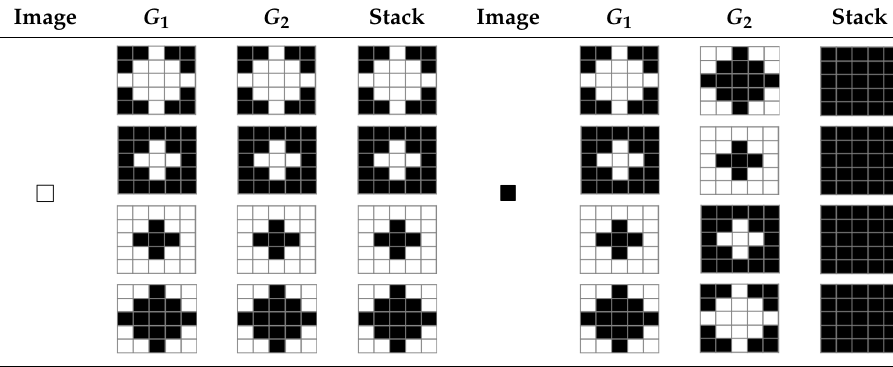
Table 4. The designed patterns for n = 4.